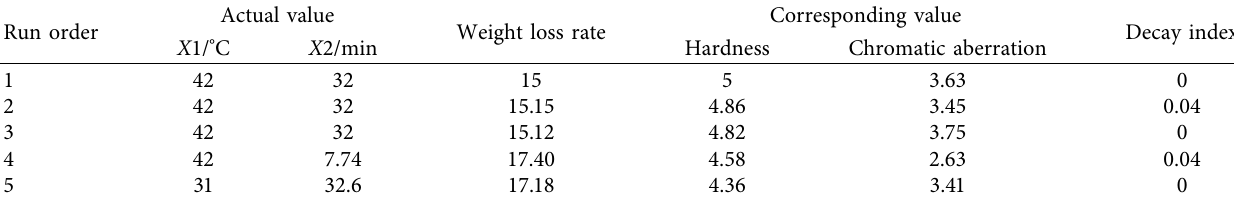
Table 4: Quality test results of each test group after storage.